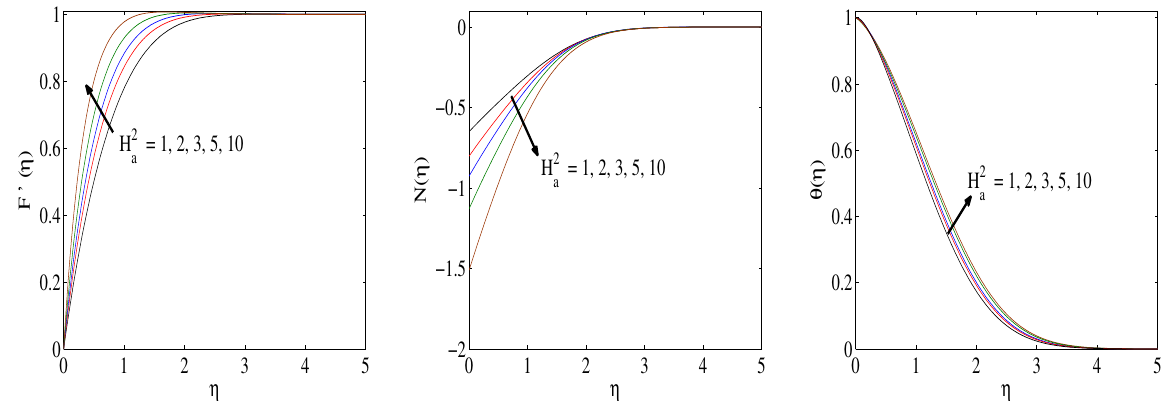
Figure 4. Velocity and angular velocity distribution under the impact of Ha factor.